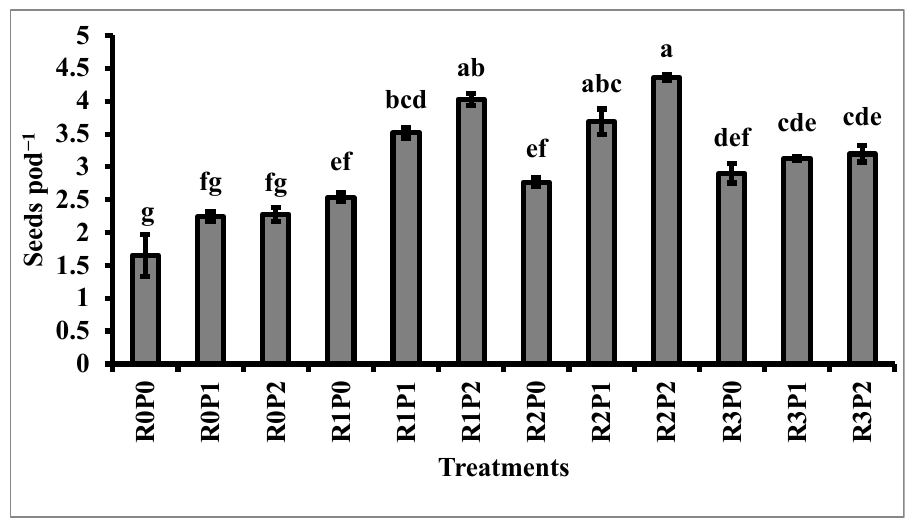
Figure 2. Interaction effect of Rhizobium japonicum and Pseudomonas striata on seeds pod − 1 of soybean, (mean ± SE, n = 3); R 0 : Control (no nitrogen and R. japonicum ), R 1 : 100% N without R. japonicum , R 2 : 50% N with R. japonicum , R 3 : only R. japonicum inoculant, P 0 : Control (no P and no P. striata ), P 1 : 100% P without P. striata and P 2 : 75% P with P. striata . Mean values sharing similar letters are statistically insignificant. Two-way ANOVA showed a significant interaction ( p ≤ 0.05) between R. japonicum and P. striata .